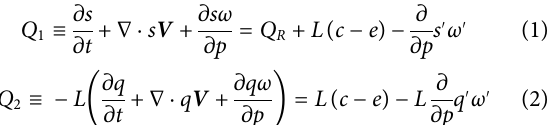
Figure 1A ; Kataoka et al., 2014), with simultaneous correlation coef fi cients of +0.88 ( Figure 1B ). Therefore, PC1 effectively the Ningaloo Niño